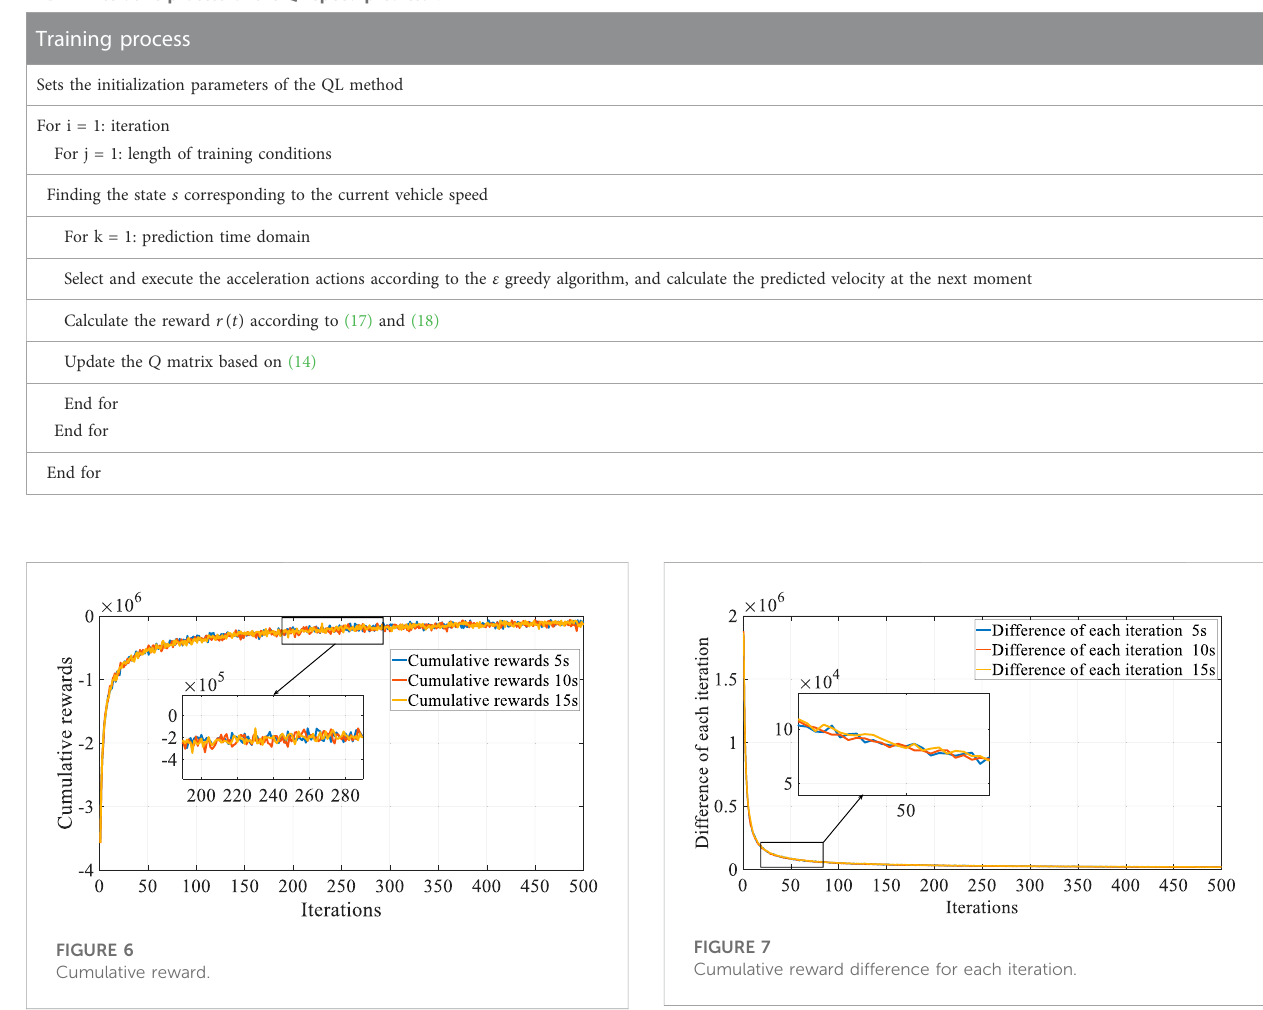
TABLE 2 Iterative process of the QL speed predictor.